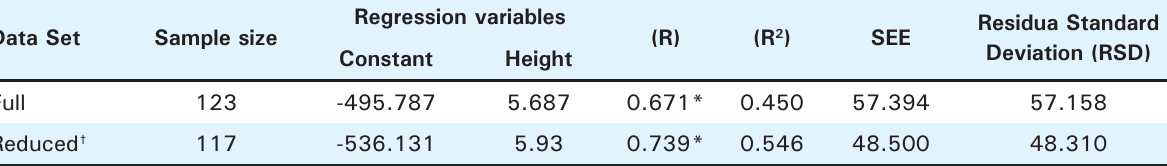
Table 3. Regression models for predicting PEFR in the Indian and Nepalese young adults (combined) Data Set